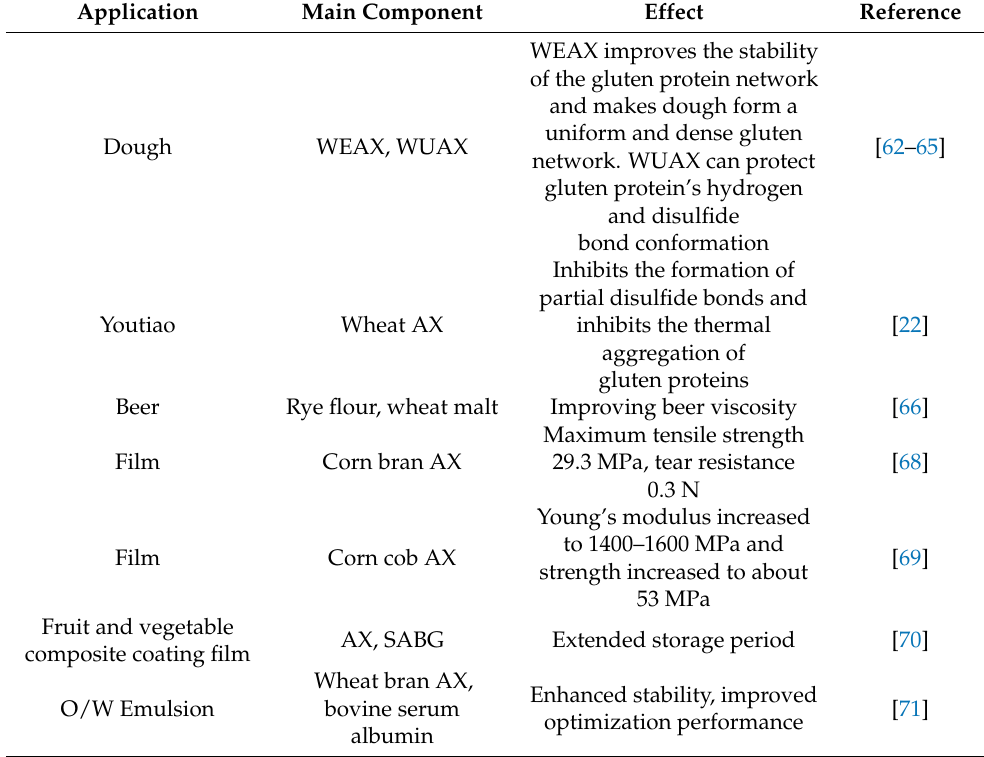
Table 3. Application of